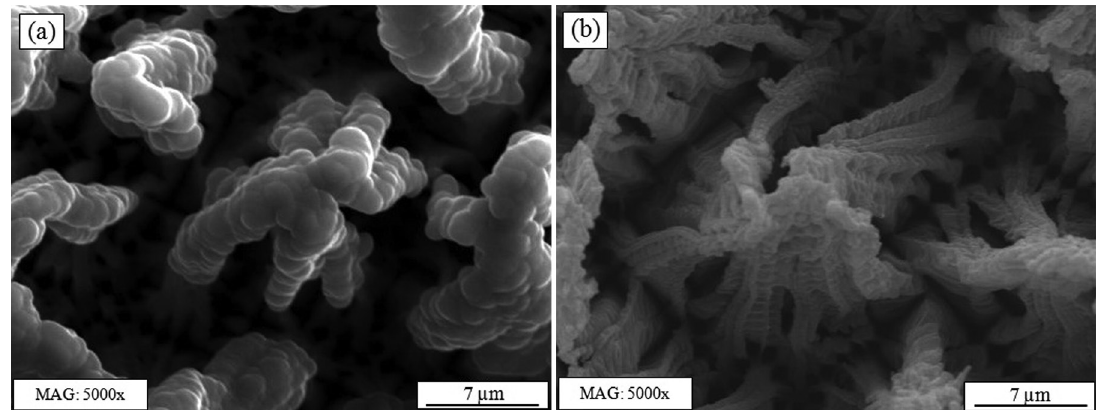
Figure 3. SEM images of BDUND grown on PS for (a) 3h and (b)